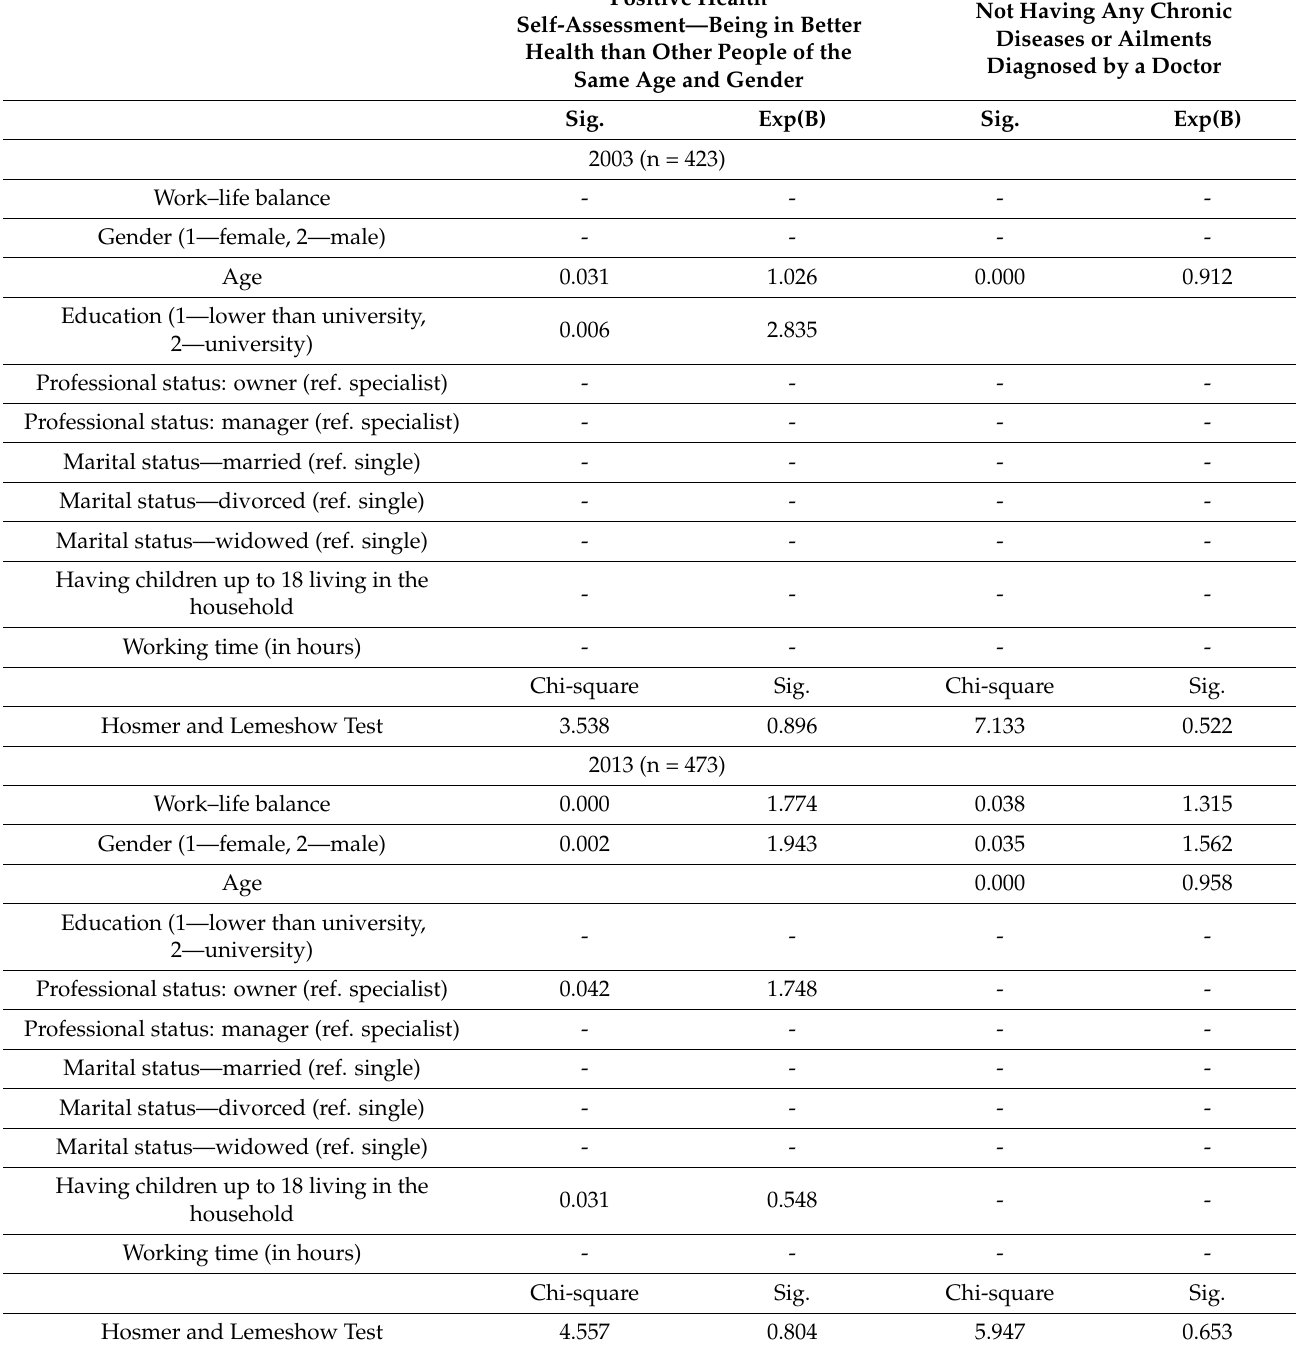
Table 2. The relationship between work–life balance and physical health controlled by socio- demographic variables. Logistic regression analysis results. Positive Health Self-Assessment—Being in Better Health than Other People of the Same Age and